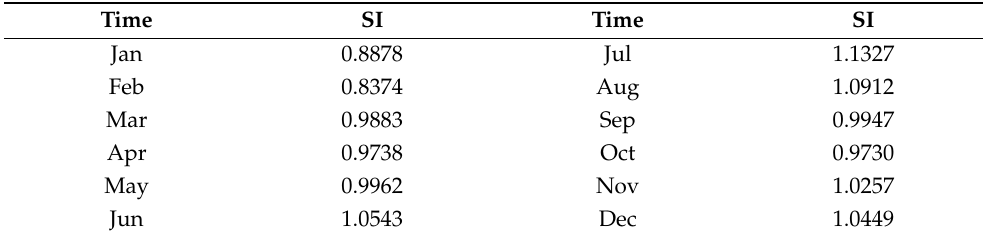
Table 3. Seasonal index of monthly industrial power